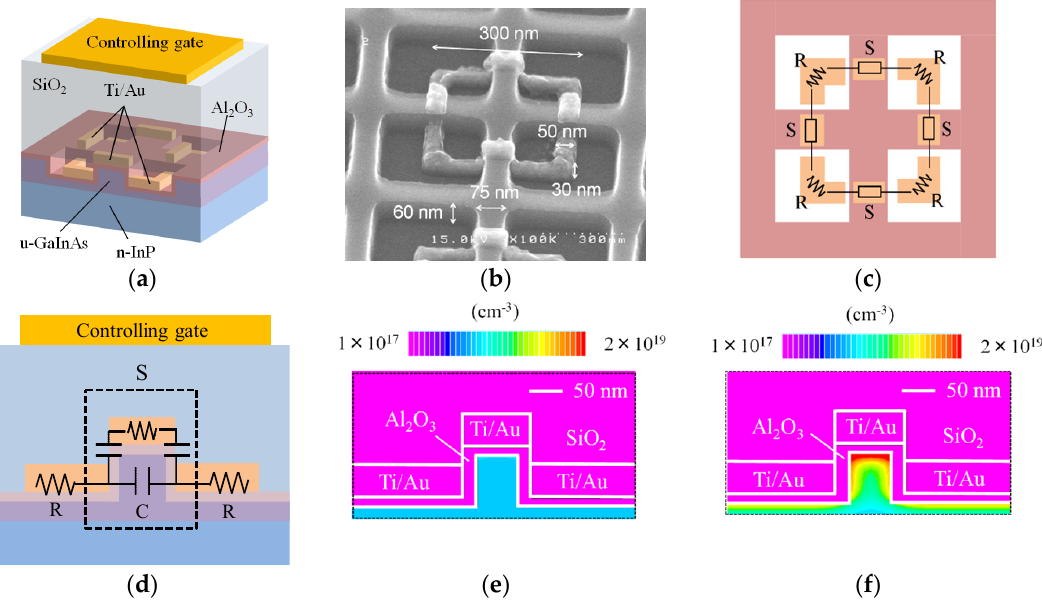
Figure 8. Gate-controlled metamaterial. ( a ) Three dimensional view of individual metamaterial; ( b ) SEM photograph around metal ring; ( c ) schematic top view of ring circuit; ( d ) equivalent circuit of gap capacitance; and ( e ) electron density induced in GaInAs fin at gate voltage = 0 V and ( f ) 20 V, simulated with three-dimensional